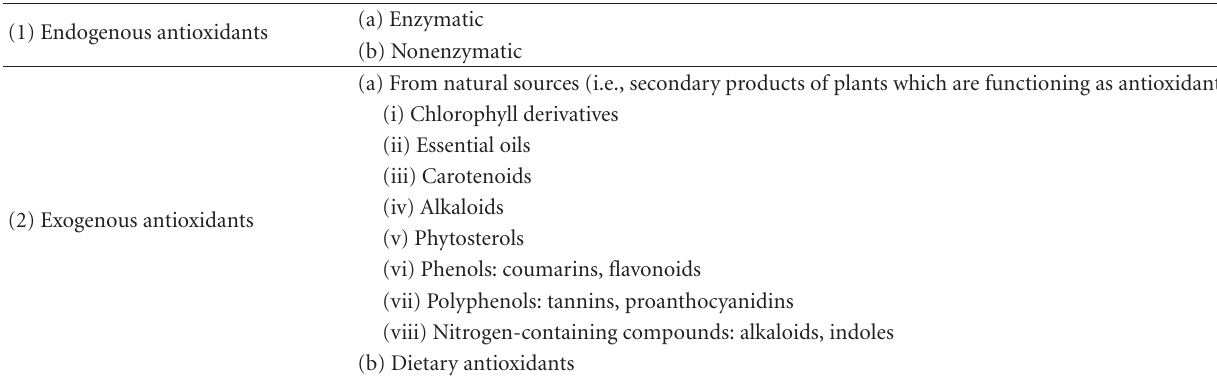
Table 2: Categories of